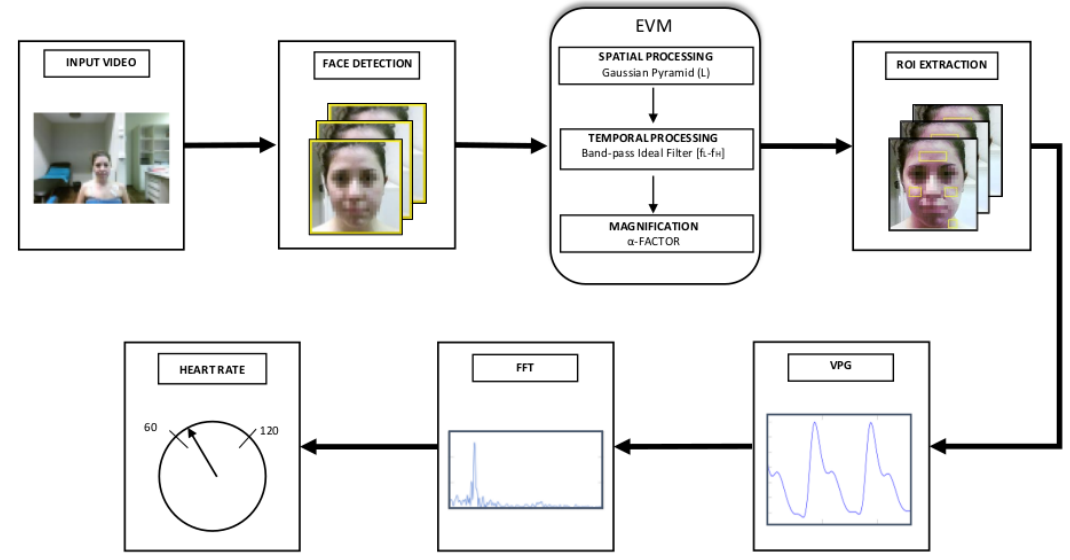
Figure 1. The main scheme of the proposed system for the computation of HR from the RGB video.